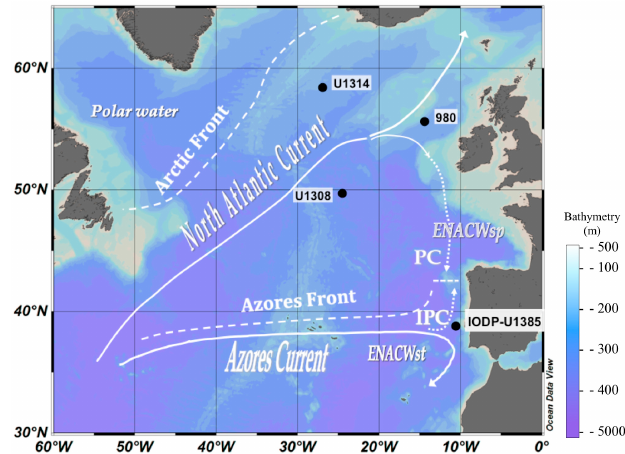
Iberian margin registered drops of 8 ◦ C in the winter SST that reached ~6.2 ◦ C [56,60]—today’s temperature being 15.5 ◦ C [61] (Figure 5). The amplitude and duration of these cooling episodes were directly related with the magnitude of the ice volume reduction. Sudden and wide-amplitude warming—up to 11 ◦ C oscillation—followed the cooling and marked the climate optimum of the succeeding interglacial [60,62]. Geosciences 2018 , 8 , x FOR PEER REVIEW